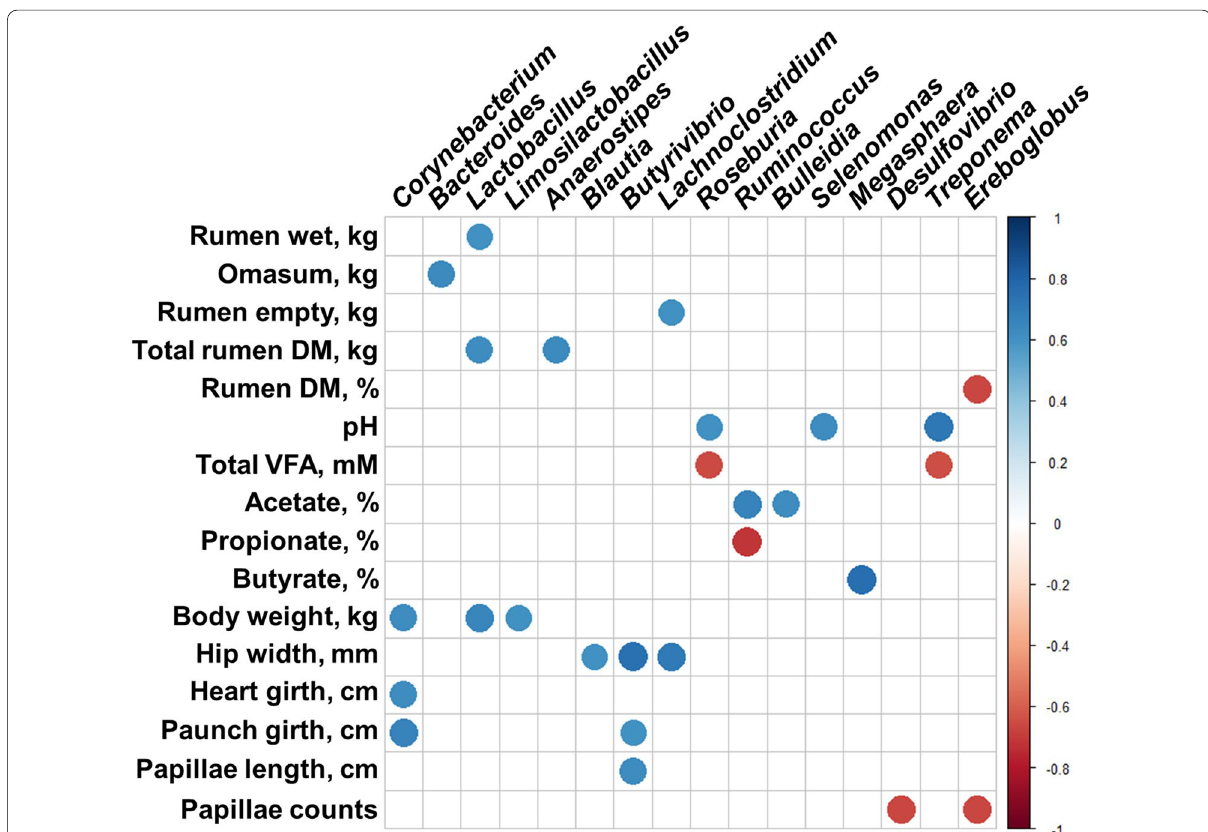
Fig. 7 Correlation between animal measurements with the relative abundance of major active bacterial and archaeal genera (occupying over 0.01% average relative abundance in at least one of the treatments). Only strong Pearson correlation coefficients ( P the plot. The correlation coefficients were based both on the size and intensity of the color based on the color key on the right